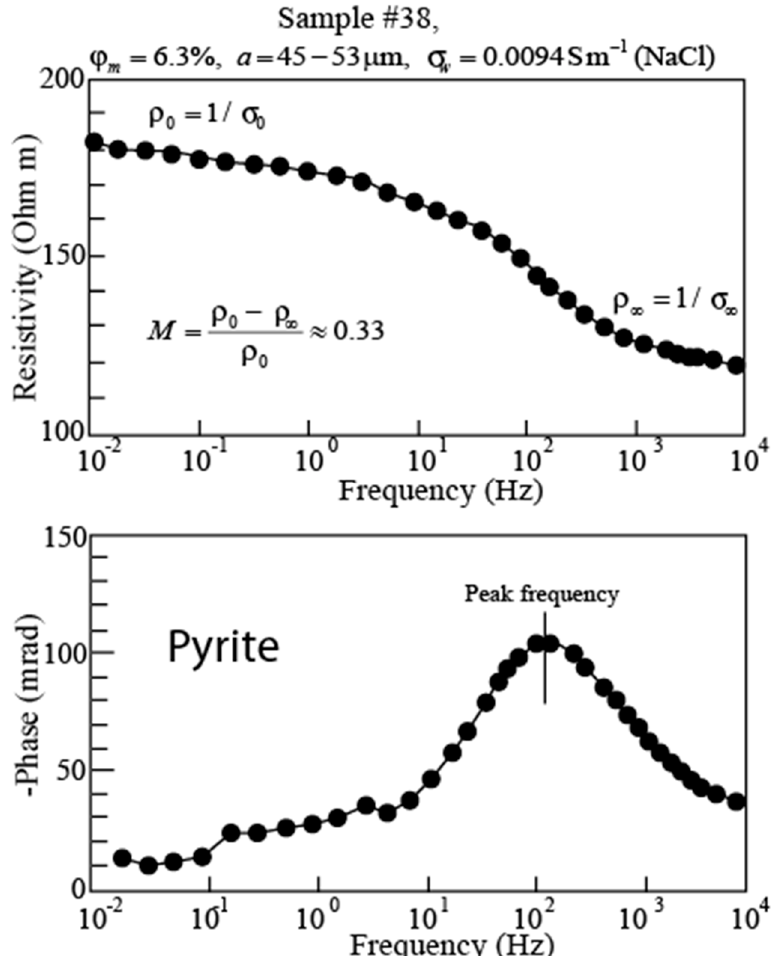
Figure 6. Complex resistivity spectrum (amplitude and phase) for a core sample with a volume fraction of 6.3% of disseminated pyrite (data from Mahan et al., 1986 [65]). At the peak frequency, the phase reaches a high value of 100 mrad, which is much higher than the phases of rocks and soils in the absence of metallic particles. The chargeability ( M ) describes the relative amplitude of the frequency dependence of the resistivity with respect to the DC resistivity ( ρ 0 ). The lines are guides for the eyes. Modified from [64].